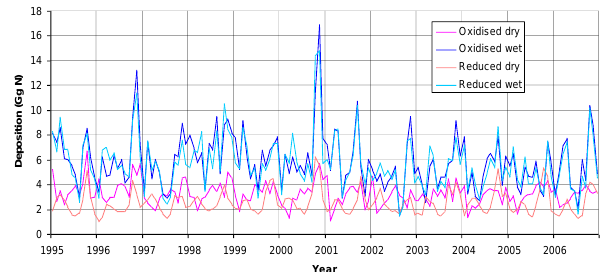
Fig. 10. Monthly deposition of oxidised dry, oxidised wet, reduced Fig. 10 . Monthly deposition of oxidised dry, oxidised wet, reduced dry and reduced wet dry and reduced wet nitrogen to the Baltic Sea basin in the period nitrogen to the Baltic Sea basin in the period 1995 – 2006. 1995–2006.